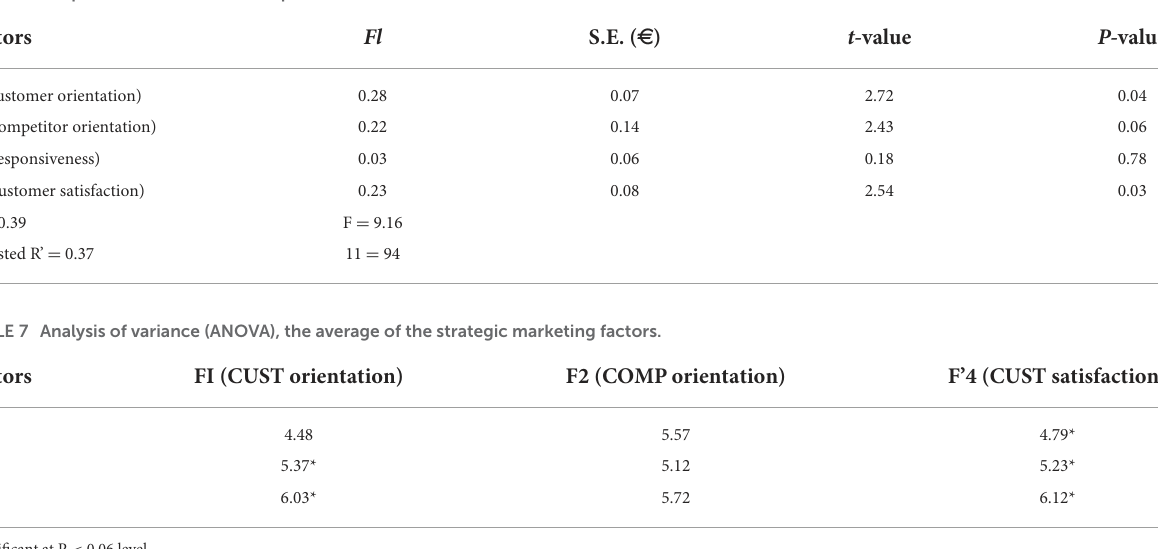
TABLE 6 F = performance in business (parameters in market orientation).